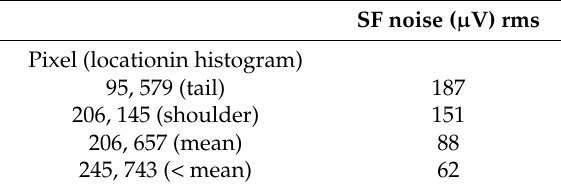
Table 5. SF read noise for selected pixels vs. t CDS (ns) and SF Ibias ( µ